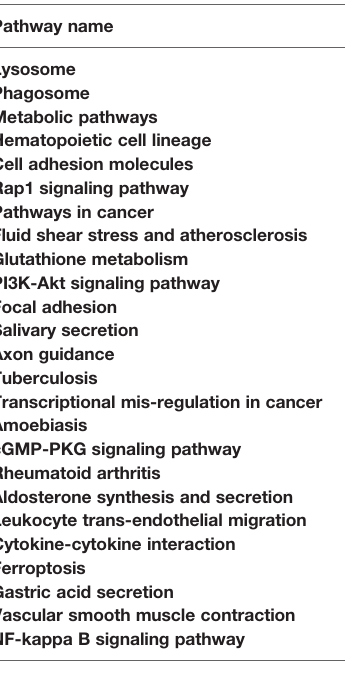
( Figure 3D , signi fi cant effect of diet, sex, and interaction — Supplementary Table 2 ). Cxcr4, Cxcl14, Ccl4, Ccl6, Ccl7, Ccl8,